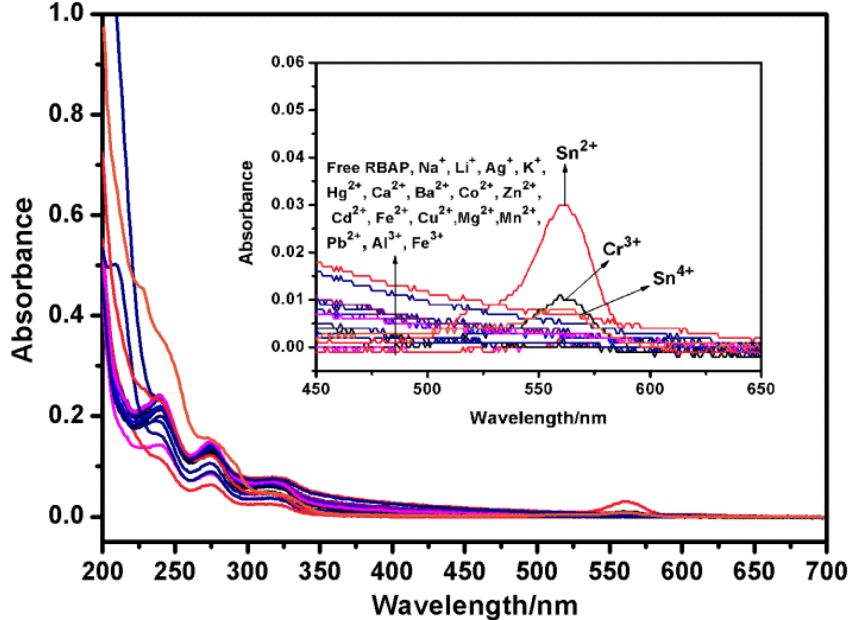
Figure 5. UV-Vis spectra of RBAP (10 μ M) in MeOH/H presence and absence of metal cations (50 μ M, 5.0 equiv.): Mg 2+ , Sn 2+ , Cr 3+ , Ag + , Ca 2+